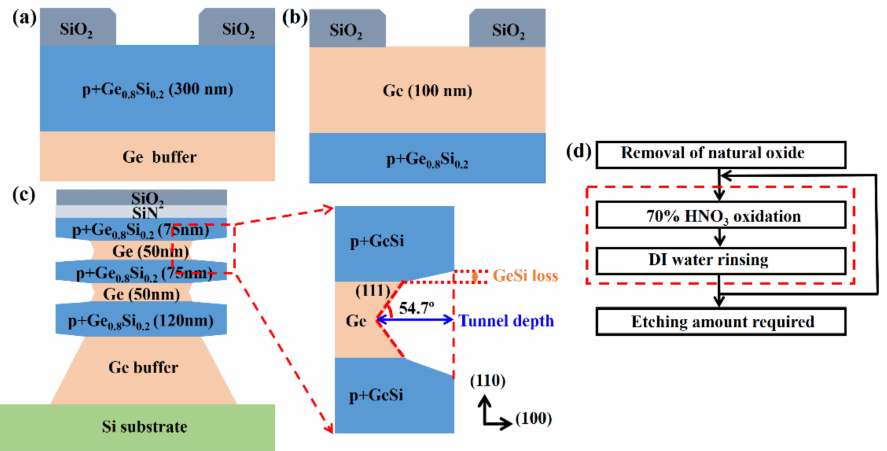
Figure 2. ( a ) Scheme of structure for p + -Ge 0.8 Si 0.2 ( a ) and Ge ( b ) with (100) flat surface; ( c ) scheme of p + -Ge 0.8 Si 0.2 /Ge stacks with SiO 2 and SiN as hard mask. The tunnel depth and GeSi loss are indicated in the insert view, selective etching of Ge at (111) planes result in a lateral angle of 54.7 ◦ . ( d ) Flow diagram of HNO 3 -DI water for p + -Ge 0.8 Si 0.2 -selective etching of Ge with